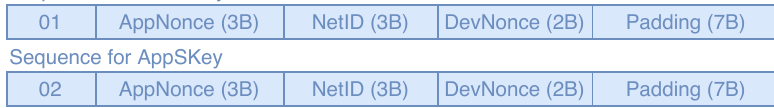
Figure 11. String for deriving session